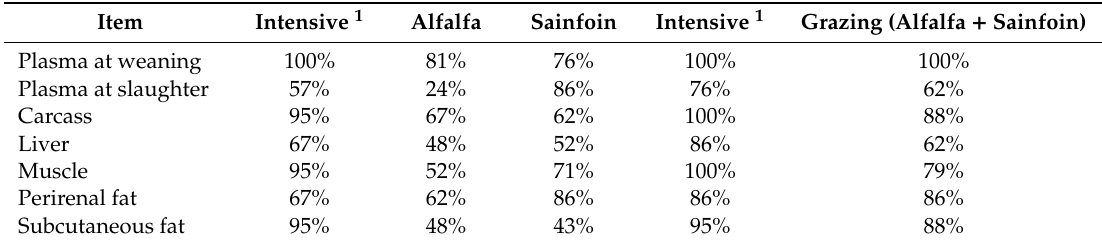
Table 4. Percentages of correctly classified samples of the lambs into the maternal feeding.